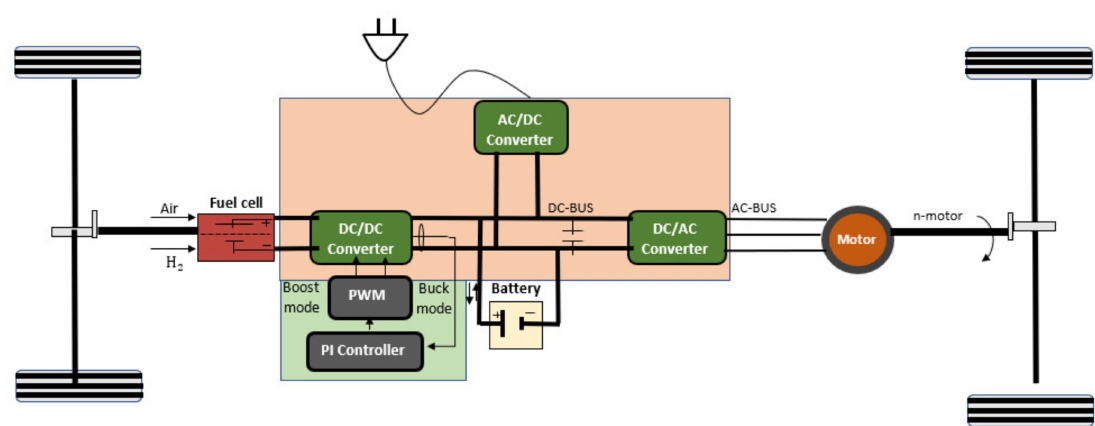
Figure 4. Typical hybrid electric car